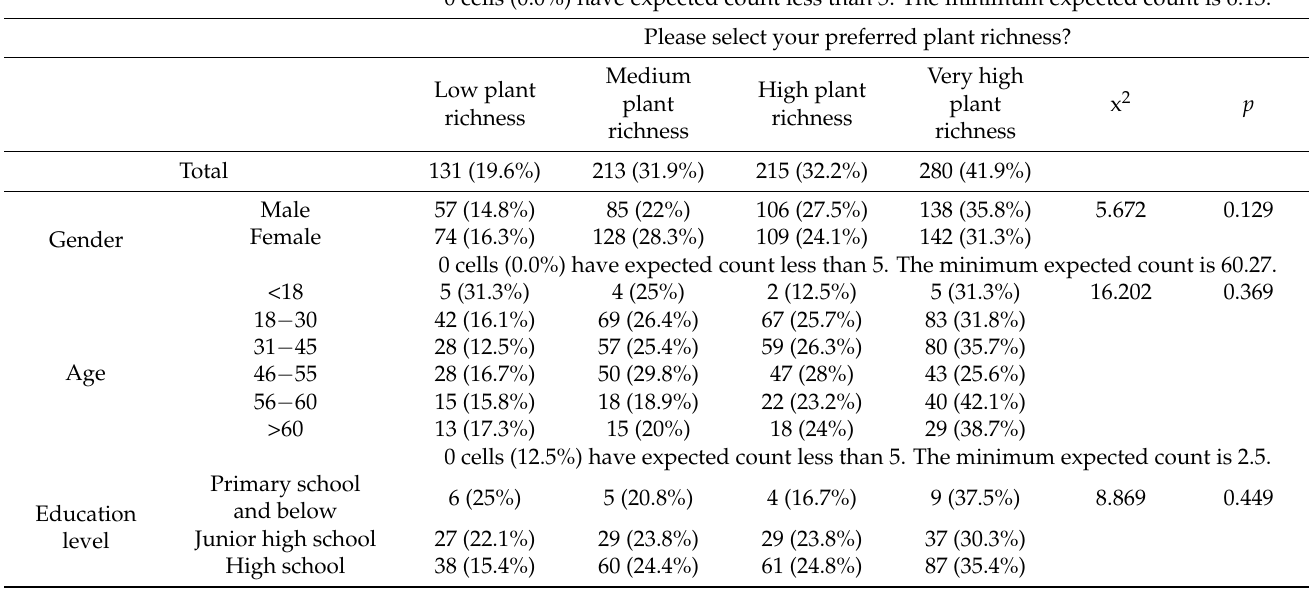
Table A2. Cont. Lawn Planting